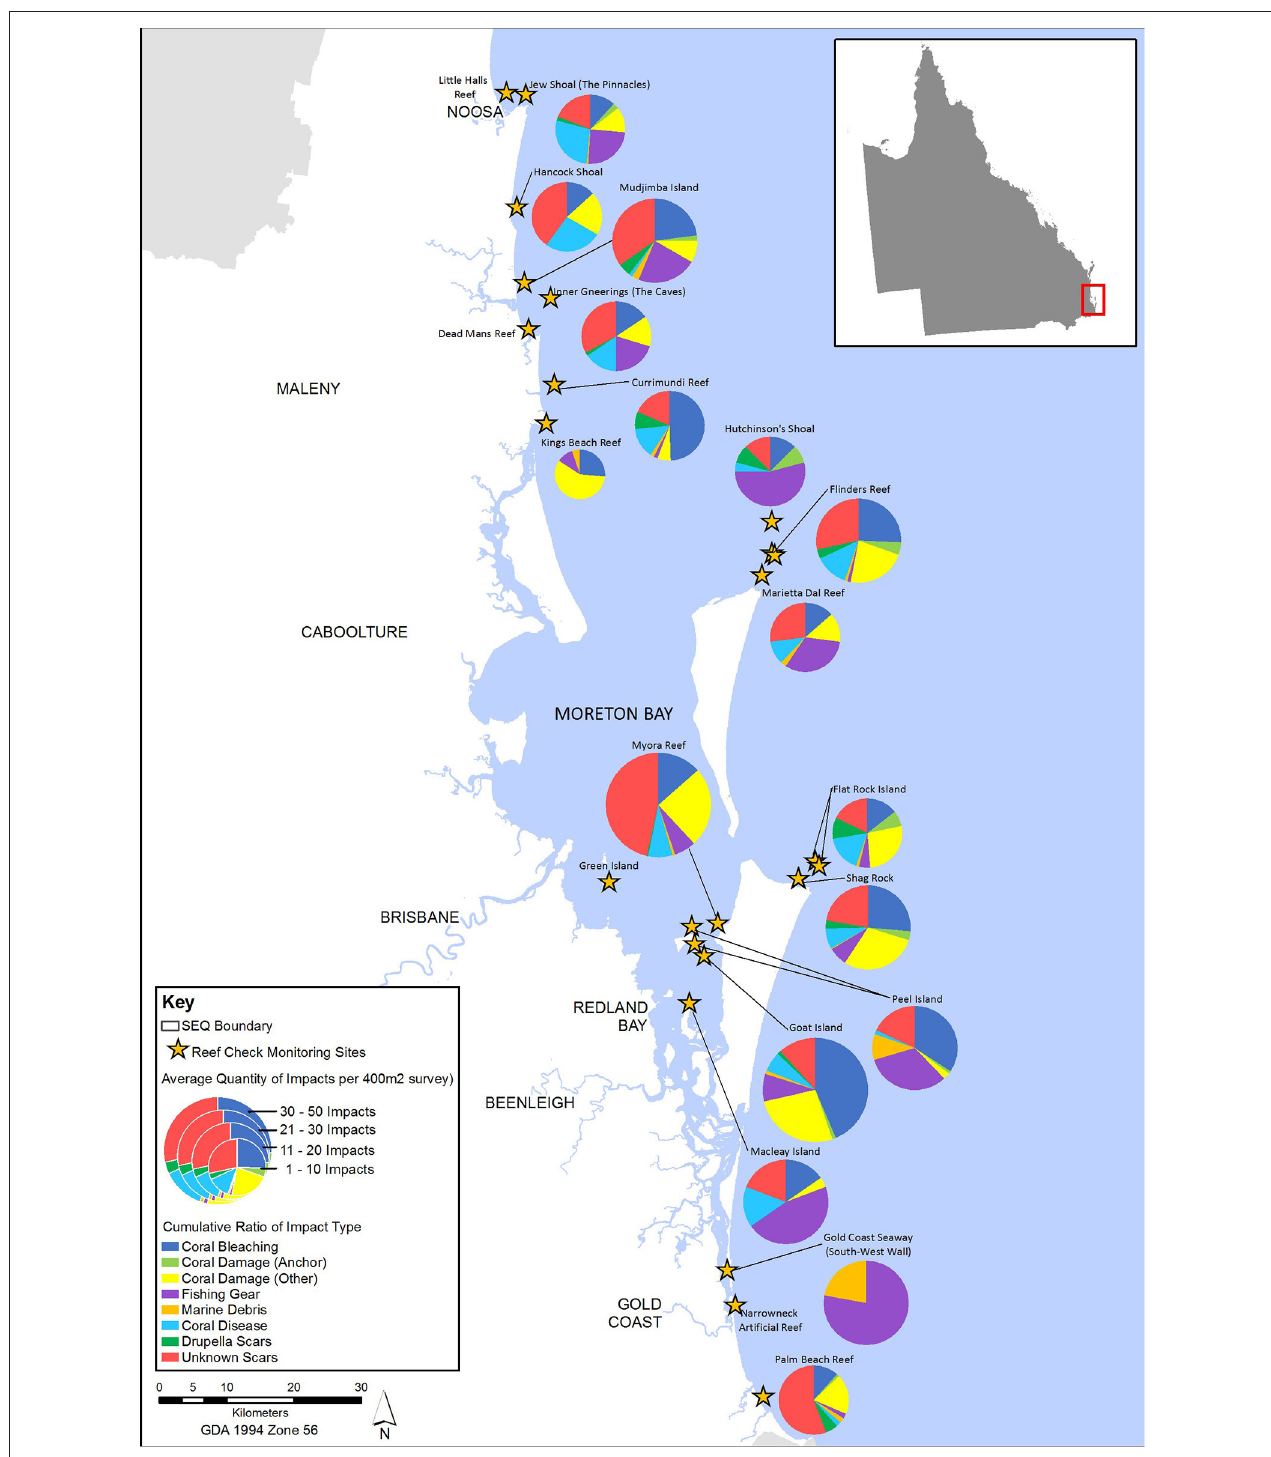
FIGURE 1 | Map of cumulative reef health impacts recorded at Reef Check Australia monitoring locations in South-East Queensland, Australia (2007–2014). Note the Gold Coast Seaway (South-West Wall) with high levels of recorded fishing gear and marine debris (no coral has been documented at this location, therefore there are no coral impacts either). Map by S. Mooney, M. Petter, M. Walker from SEQ Catchments Ltd, using RCA data.